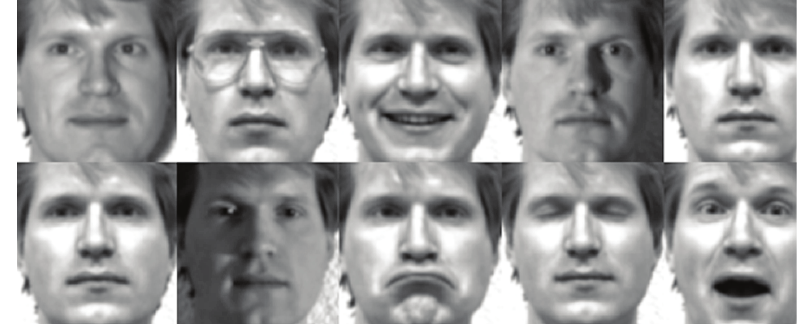
Figure 5: Extended Yale face database sample images.